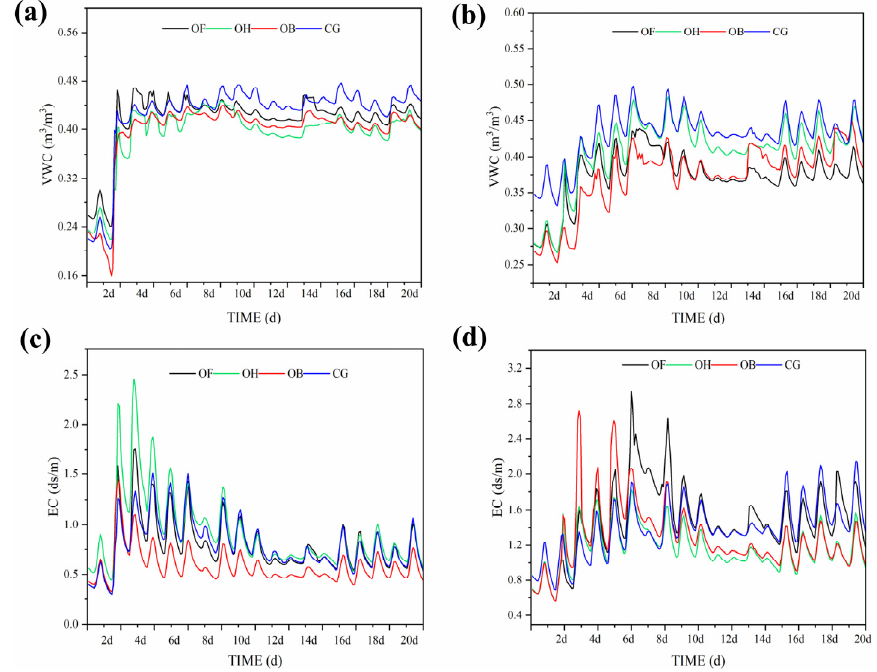
Figure 2. Variations of soil volumetric water content (( a ): 0–20 cm; ( b ): 20–40 cm) and electrical conductivity (( c ): 0–20 cm; ( d ): 20–40 cm) over time in different treatments. Table 4. Variation of SWC and EC under different cumulative infiltration water